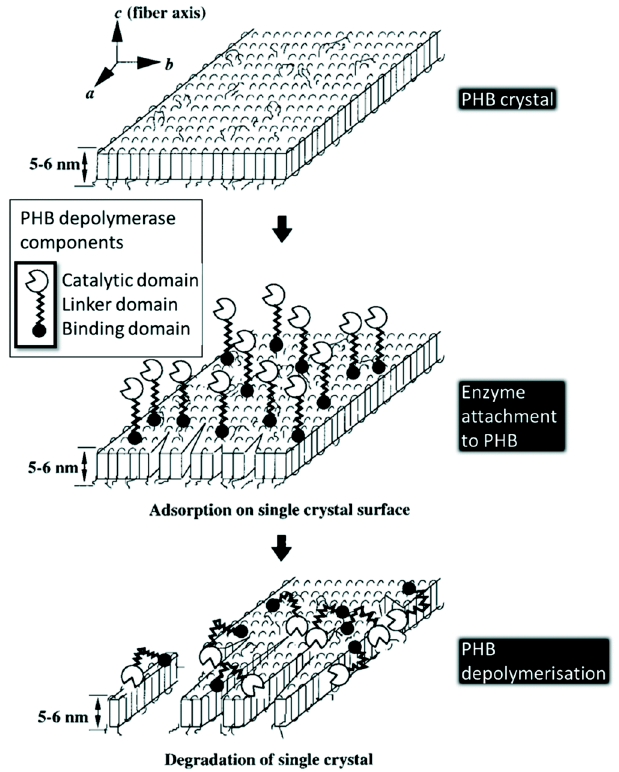
Figure 8. A Single PHB crystal enzymatic degradation by PHB depolymerase [280].